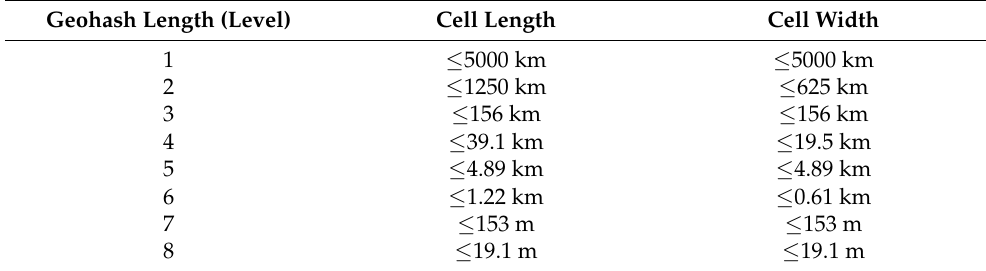
Table 2. Area of each level Geohash